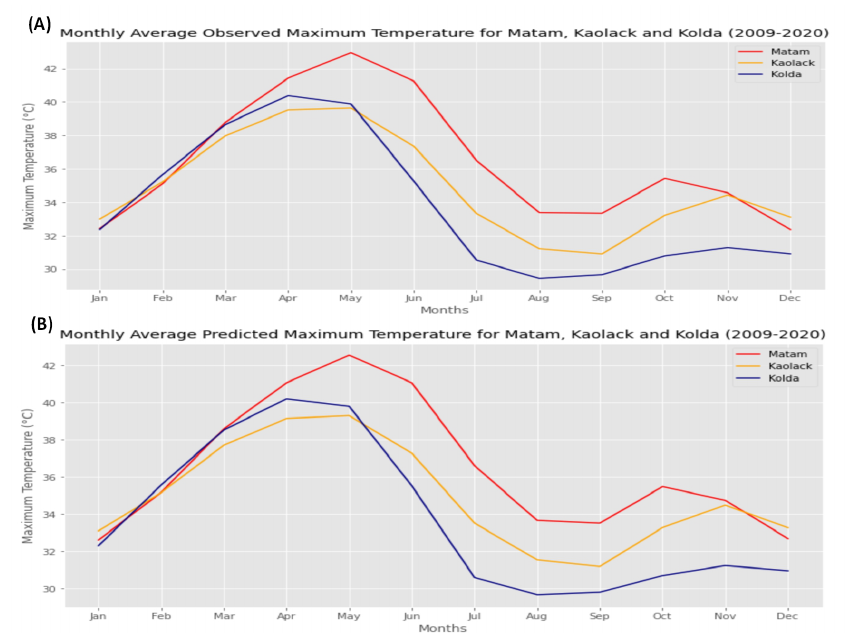
Figure 25. Monthly Average Observed and Forecasted Maximum Temperature for Matam, Kaolack and Kolda (2009–2020).